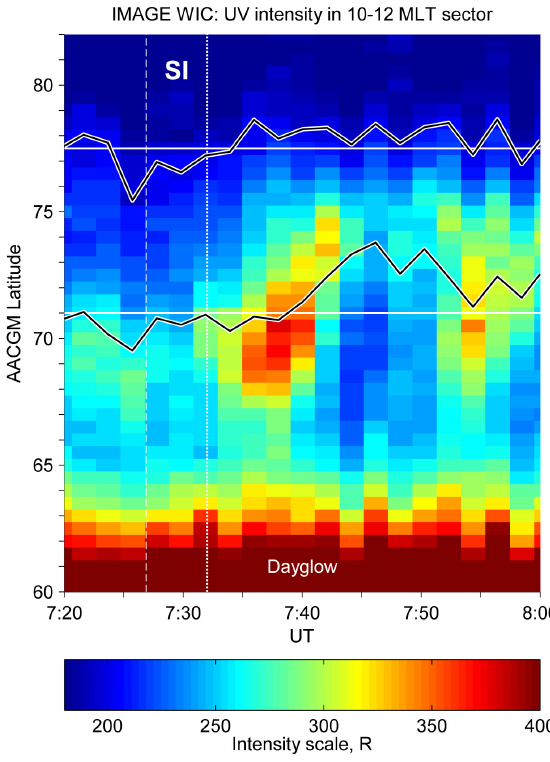
Fig. 5. A “keogram” made from the UV images at about 11 MLT (at the meridian of Svalbard). White vertical dashed and dotted lines indicate the moments of the pressure pulse arrival at the bow shock and its detection at the low-latitude magnetic observatory Bangui, respectively. Black lines indicate the position of the middle and poleward boundaries of the auroral oval. Horizontal white lines at 71 ◦ and 77.5 ◦ of the AACGM latitude indicate the range of latitudes at which the ground-based optical observations were made by a TV all-sky camera at Barentsburg